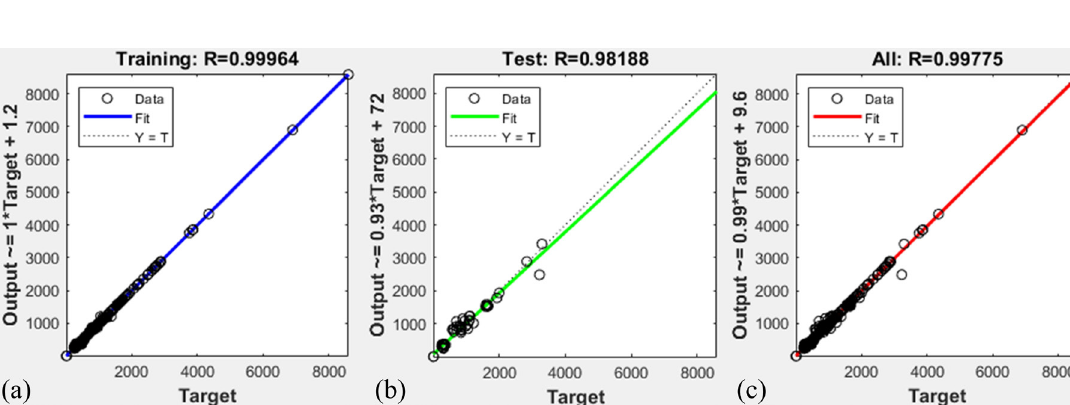
Figure 6. First ANN R2 scores (a) training 99.96%, (b) test 98.2% and (c) all 99.77%.